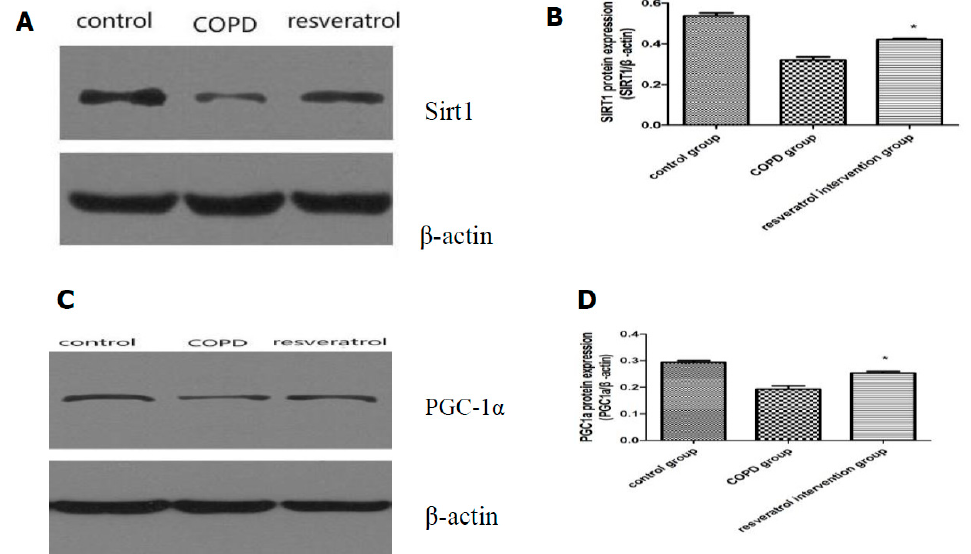
Figure 6. SIRT1 and PGC-1 α protein expression: ( A ) representative western blots of SIRT1 and ( B ) the results of the quantitative densitometric analysis. SIRT1 protein decreased in the lungs of COPD rats (n = 10). Lungs of resveratrol rats (n = 10) showed higher levels of SIRT1; ( C ) Representative western blots of PGC-1 α and ( D ) the results of the quantitative densitometric analysis. PGC-1 α protein decreased in the lungs of COPD rats. Lungs of resveratrol rats (n = 10) showed higher levels of PGC-1 α . * significant ( p < 0.05) vs. with COPD rats (n = 10).